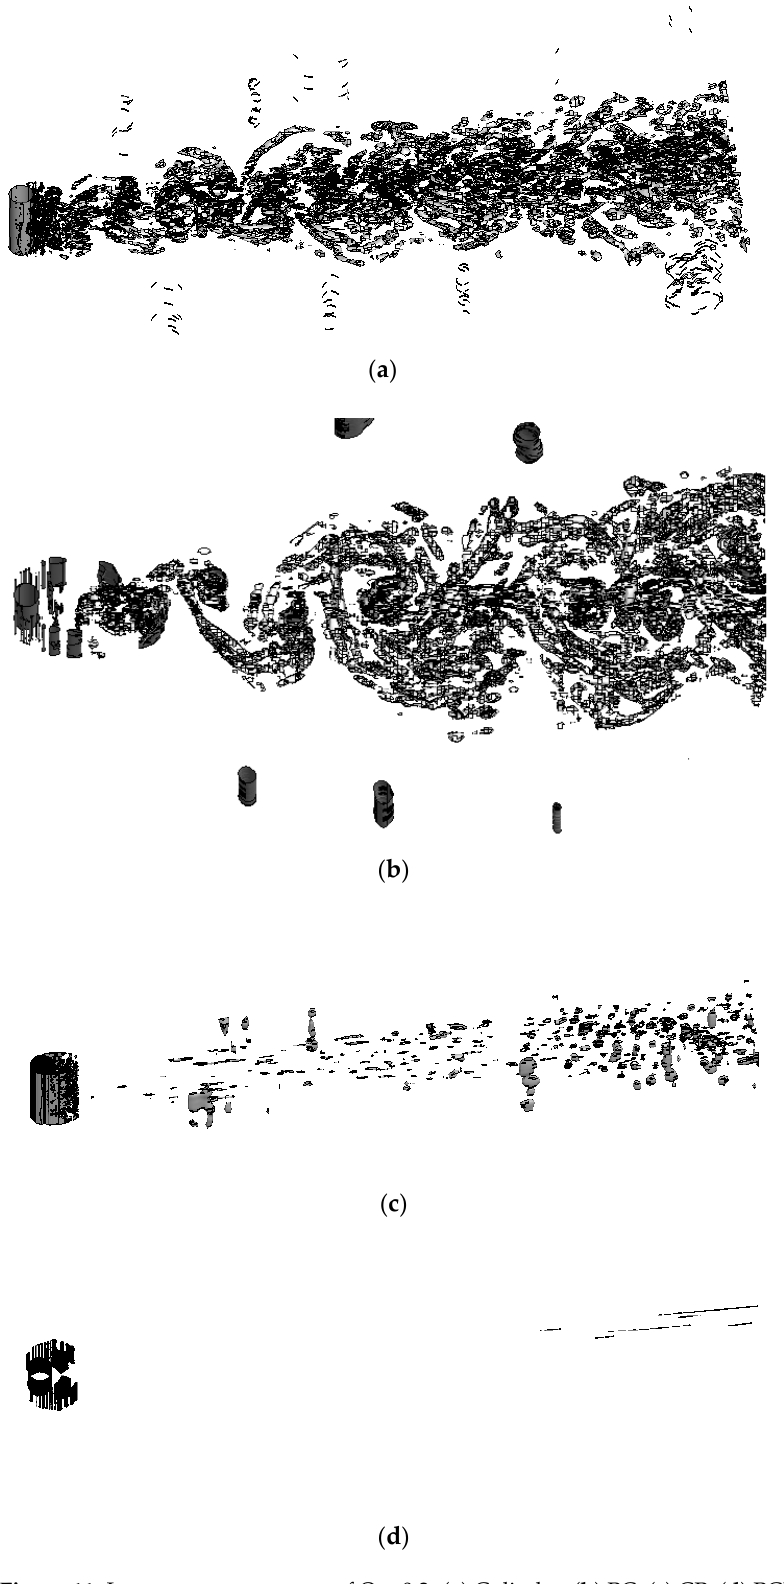
Figure 11. Instantaneous contour of Q = 0.2: ( a ) Cylinder; ( b ) PC; ( c ) CP; ( d ) PCP.